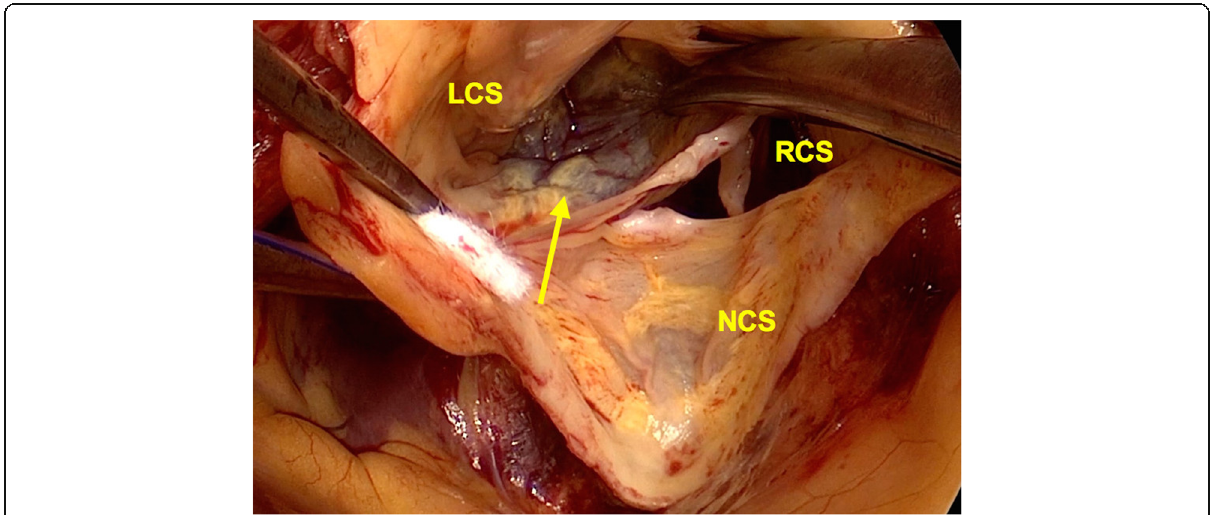
Fig. 2 Intraoperative view showing the orifice of the left sinus of Valsalva aneurysm with wall defect of the aortic annulus. Ventricular muscles are